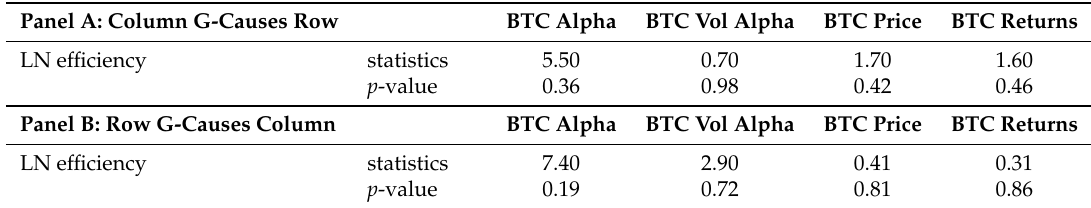
Table 3. Testing for granger-causality. The table reports the results of the Toda–Yamamoto test (Toda and Yamamoto 1995). In Panel A we test whether column variables Granger-cause the row variable, while the opposite for Panel B.